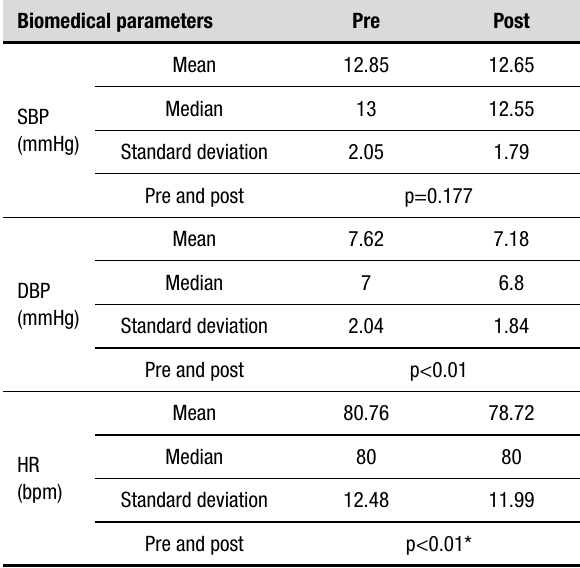
Table 4. Effects on biomedical parameters of intervention group in the pre- and post-session period at multisensory environments. Biomedical